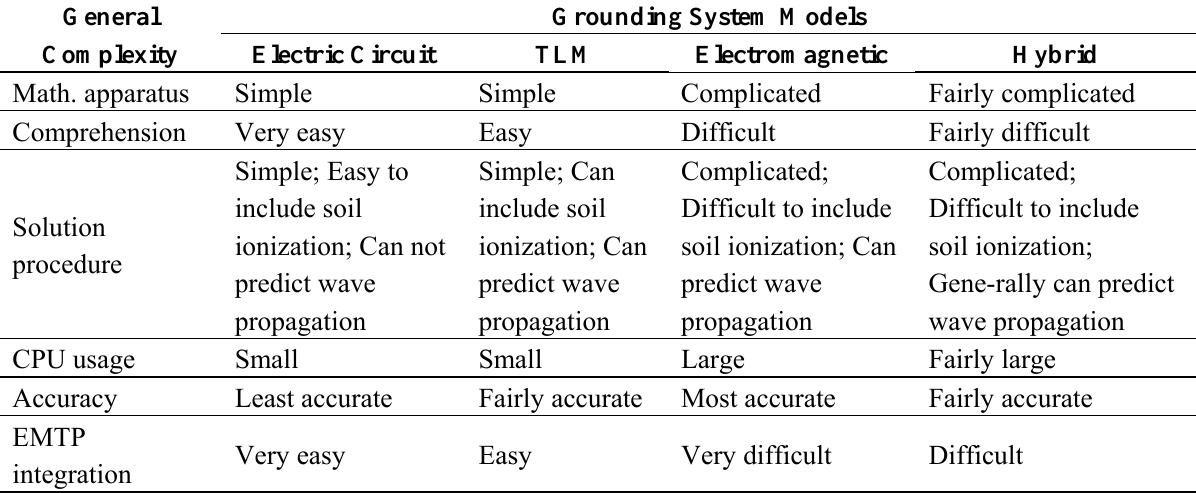
Table 1. Comparison of different approaches for EMTP modeling the transient grounding system